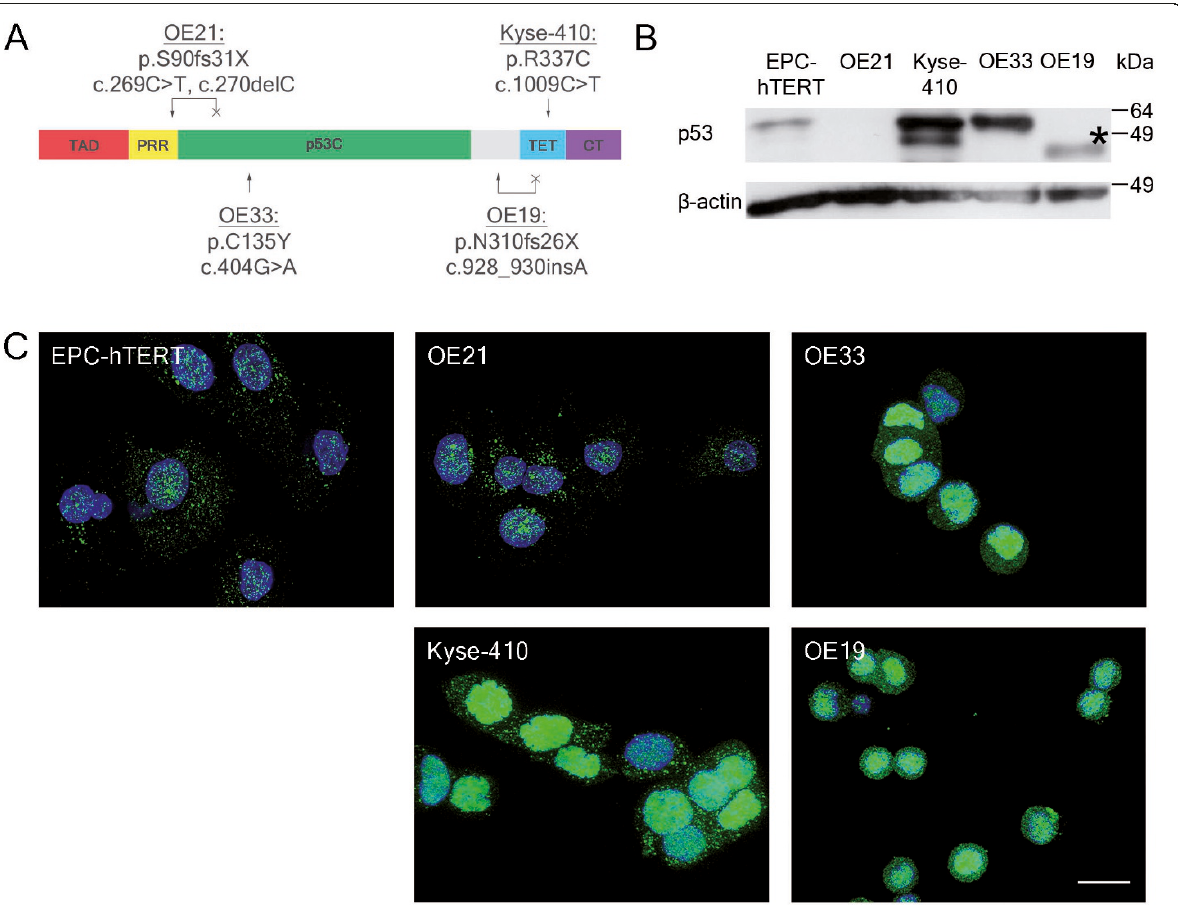
Figure 5 p53 in normal esophageal epithelial cells and esophageal cancer cells . A . The p53 protein and its domain structure (modified from [39]). The normal esophageal epithelium cell line EPC-hTERT carries no p53 mutation whereas all esophageal cancer cell lines exhibit mutations of p53, but each in a different functional domain. Mutations are indicated by arrows ( ↓ ) and possible protein truncations by crosses (×). B . Photograph of p53 protein expression by immunoblot analysis, representative for 3 independent experiments. Due to mutations, the p53 protein of OE21 and OE19 is truncated, resulting in protein masses of about 14 kDa and 40 kDa, respectively. For OE19 this shift in protein mass was seen at the immunoblot (asterisks), the 14 kDa protein of OE21 cells was below the size of detectable proteins in these 10% SDS gels. b - Actin served as laoding control. C . p53 indirect immunofluorescence (green) and DNA counterstaining by DAPI (blue). Mutated p53 accumulates in the nucleus of Kyse-410, OE33 and OE19 cells. The truncated p53 protein of OE21 cells lacks almost all protein domains and is only weakly expressed. Refer to text for discussion of p53